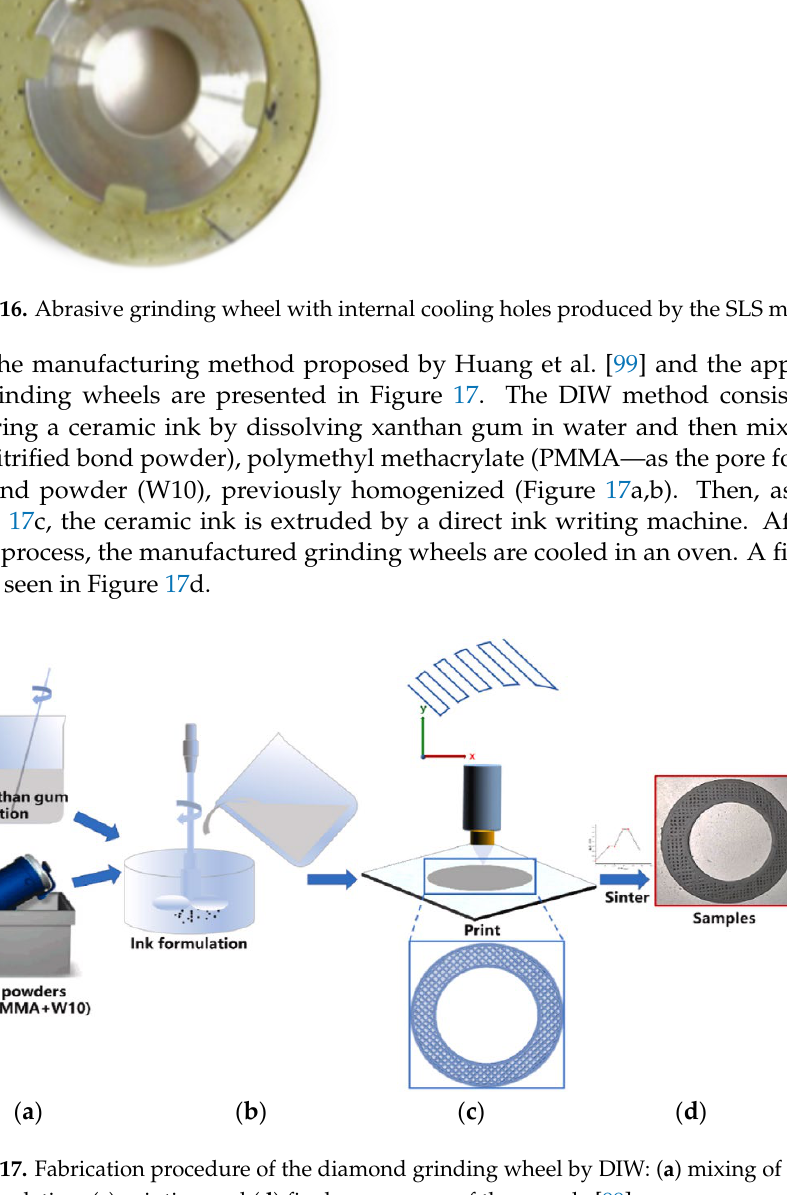
it can produce three-dimensional grooves, eliminating the need for tool reconditioning.